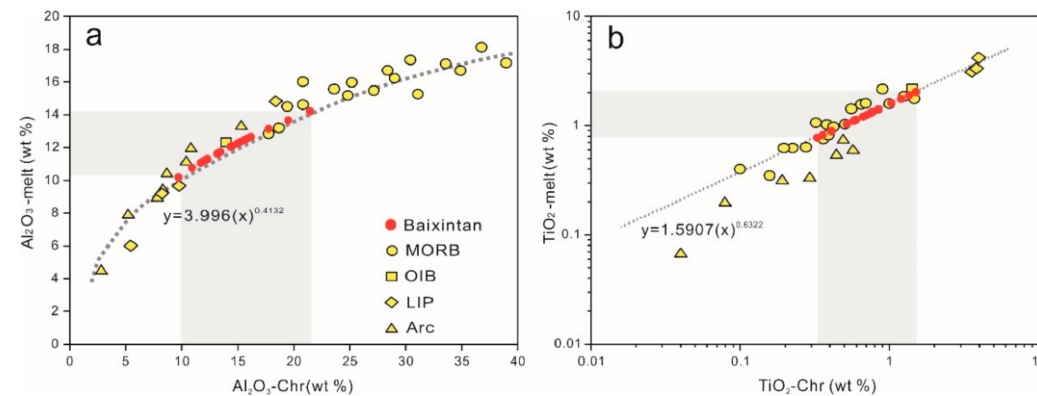
Figure 9. Estimated composition of the parental melt in equilibrium with chromite from the Baixintan complex: ( a ) plot of Al 2 O 3 -melt–Al 2 O 3 -Chr and ( b ) plot of TiO 2 -melt–TiO 2 -Chr. The ordinate is the calculatedcompositionsofparentalmagma. Theabscissaisthecompositionsofchromite. Theregression lines and data of MORB, OIB, LIP, and Arc are derived from Kamenetsky et al. [8] and Rollinson [9]. Only primary type I chromite is used in calculations. MORB: middle ocean ridge basalt, OIB: ocean island basalt, IAT: island-arc tholeiite, and LIP: large igneous